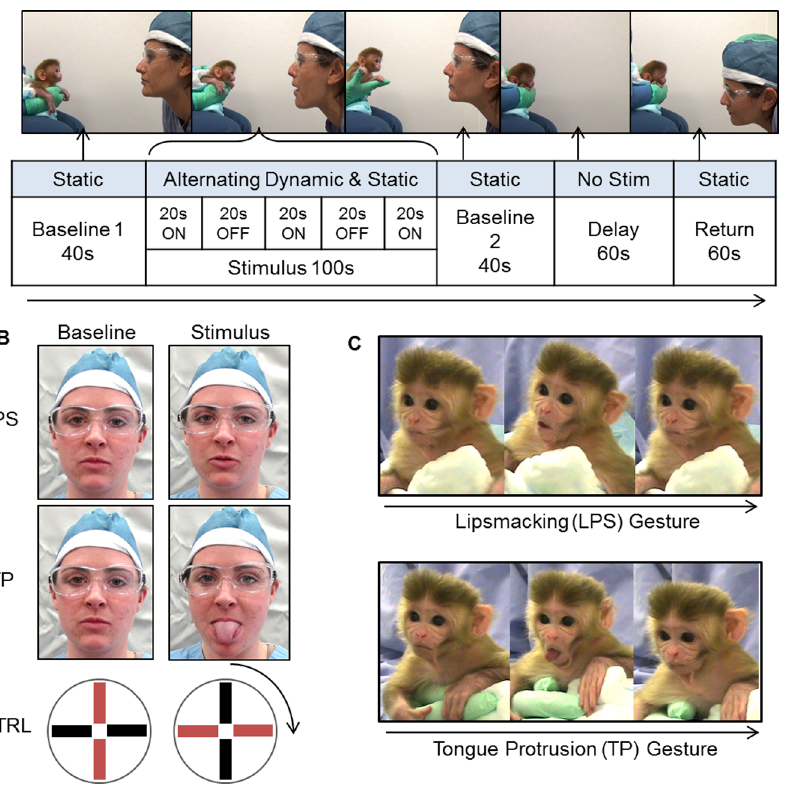
Figure 1. Methodological details. Procedure (A), examples of lipsmacking, tongue protrusion, and control stimuli (B), and examples of infants’ gestures (C). Human models portrayed here have given written informed consent, as outlined in the PLOS consent form, for publication of their photographs.